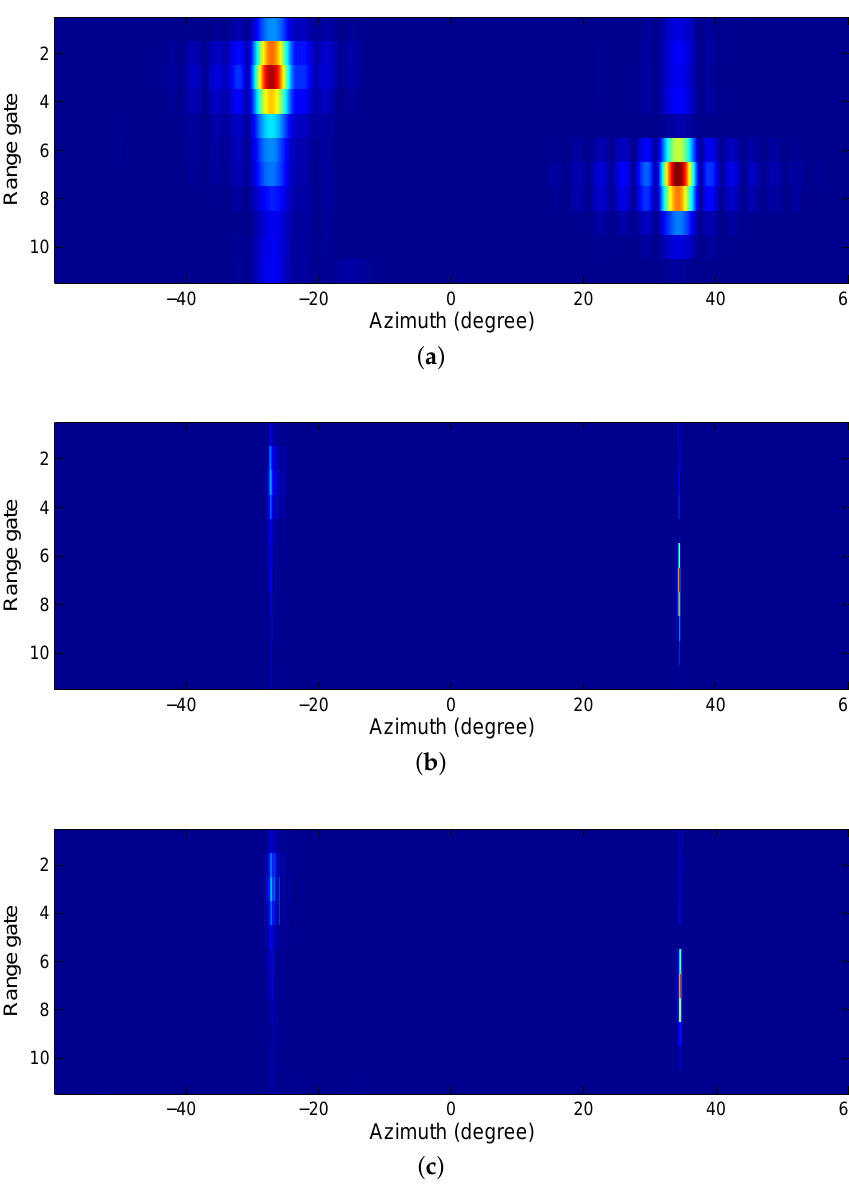
Figure 17. Imaging results of two ships by different methods. ( a ) Original real radar data; ( b ) Proposed MMAP; ( c ) Proposed